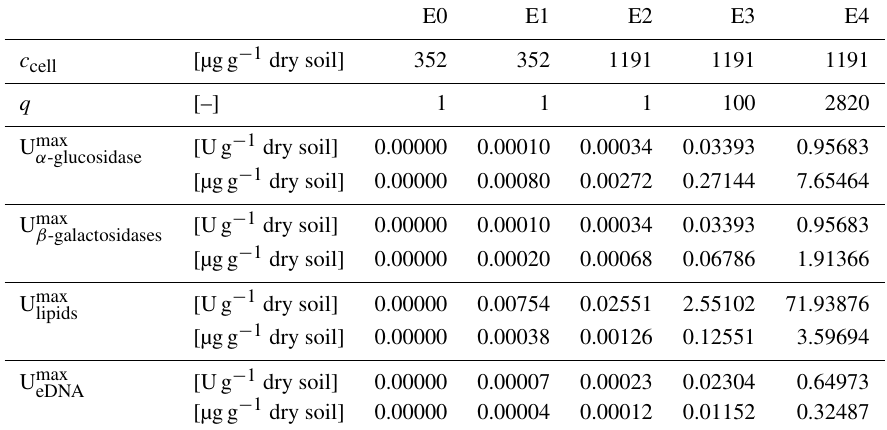
Table 3. Specific scenario parameters of the variants E0, E1, E2, E3 and